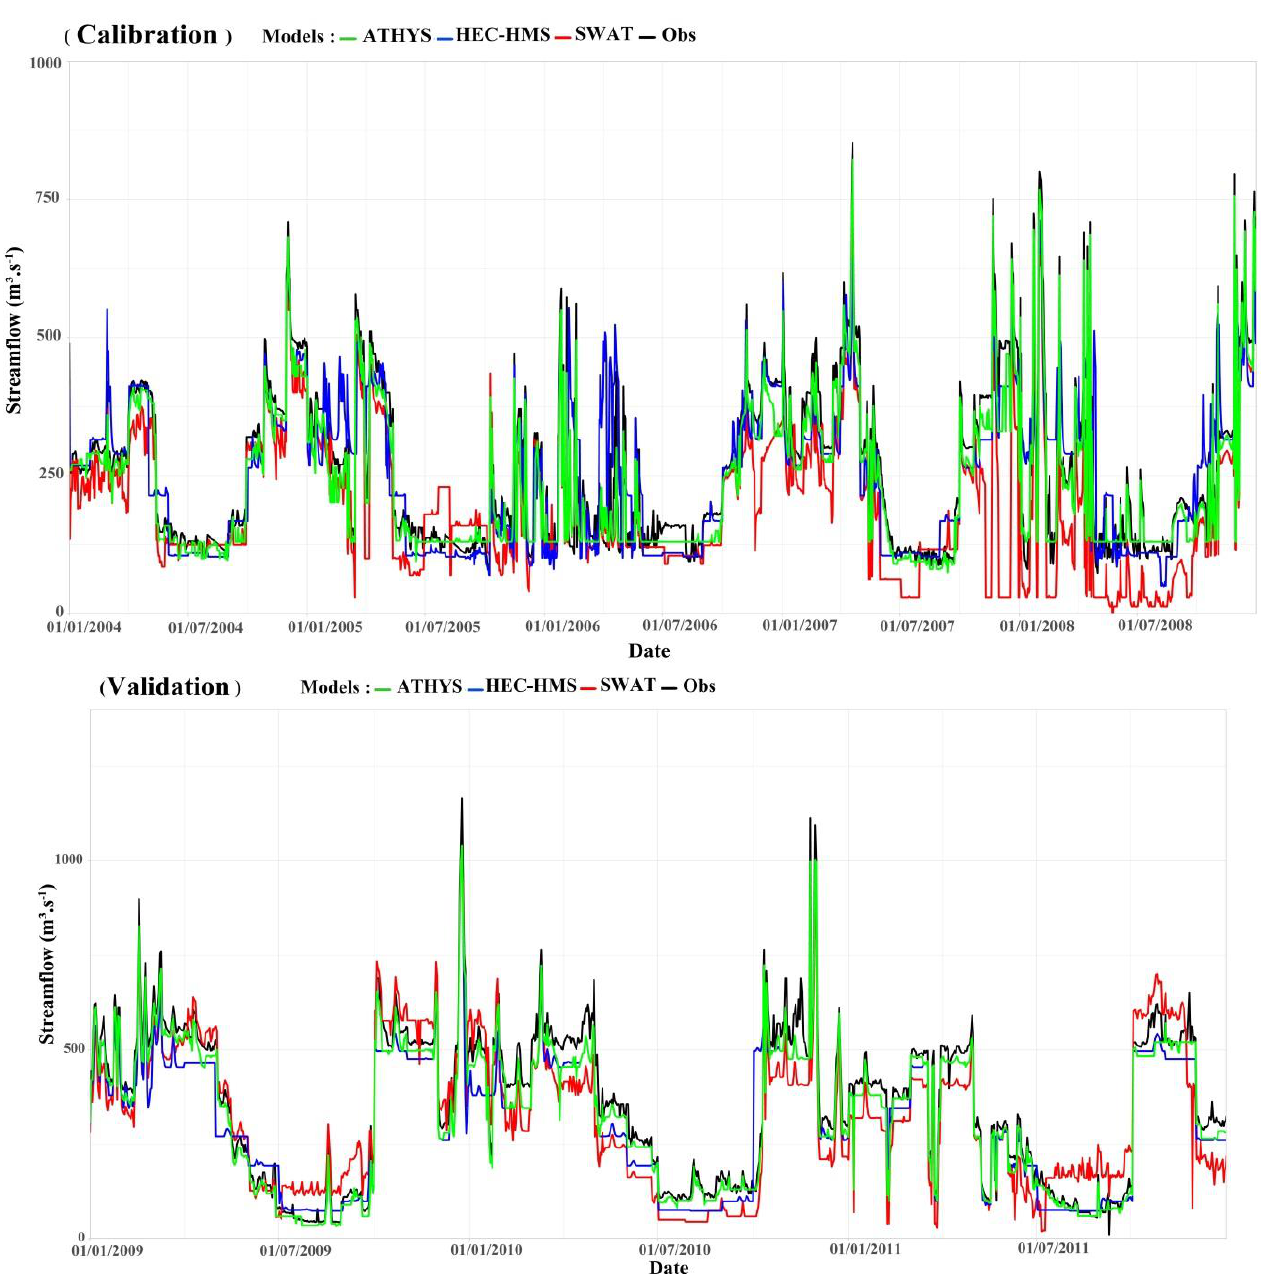
Figure 6. Differences between the observed and simulated daily discharge by the hydrological models HEC-HMS, SWAT, and ATHYS during the calibration and validation periods.